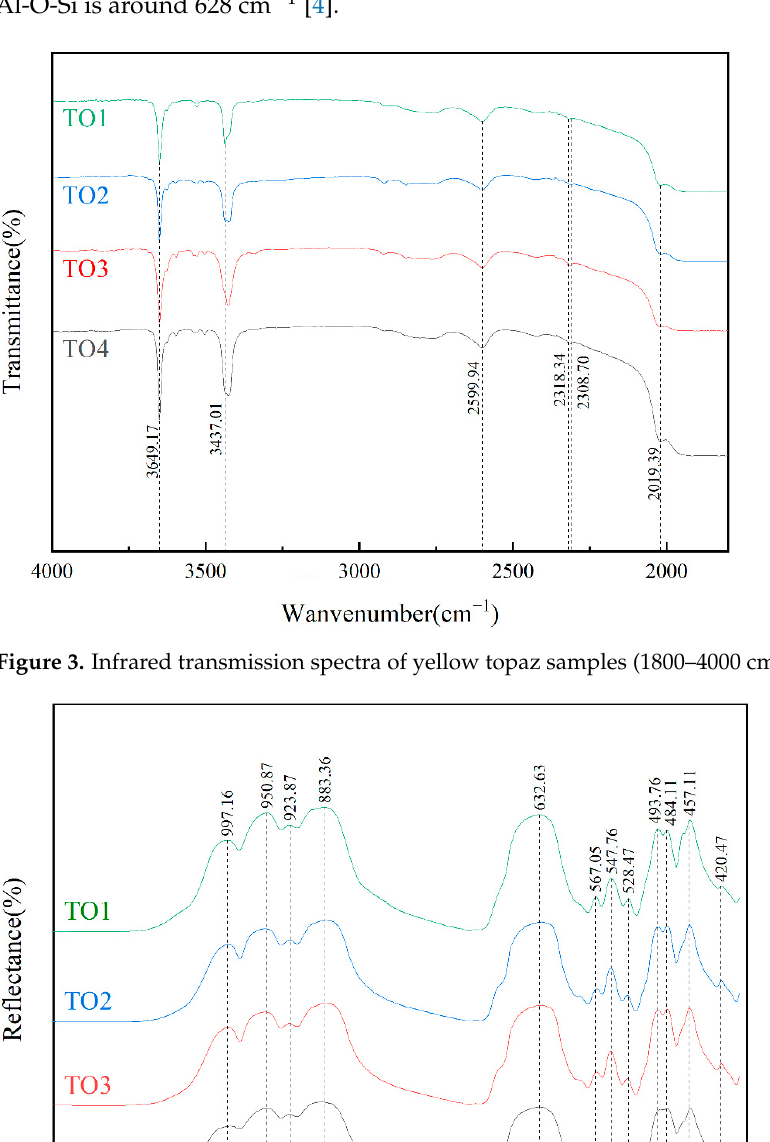
Figure 3. Infrared transmission spectra of yellow topaz samples (1800–4000 cm − 1 ).